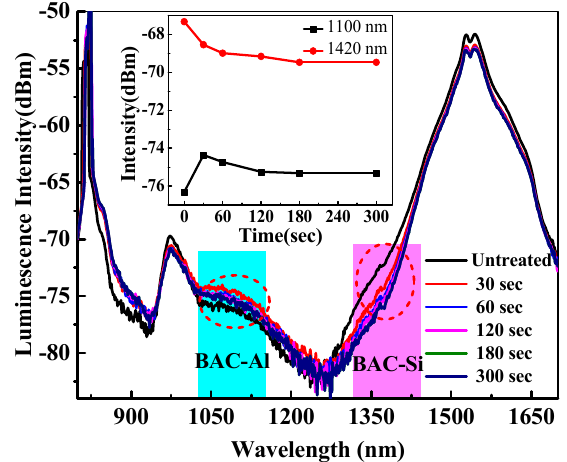
Figure 4. Luminescence spectra of Bi/Er co-doped fibers with an 830 nm pump excitation after UV irradiation treatment. And the changes of luminescence intensity at ~1100 nm (black line) and 1420 nm (red line) were inserted.